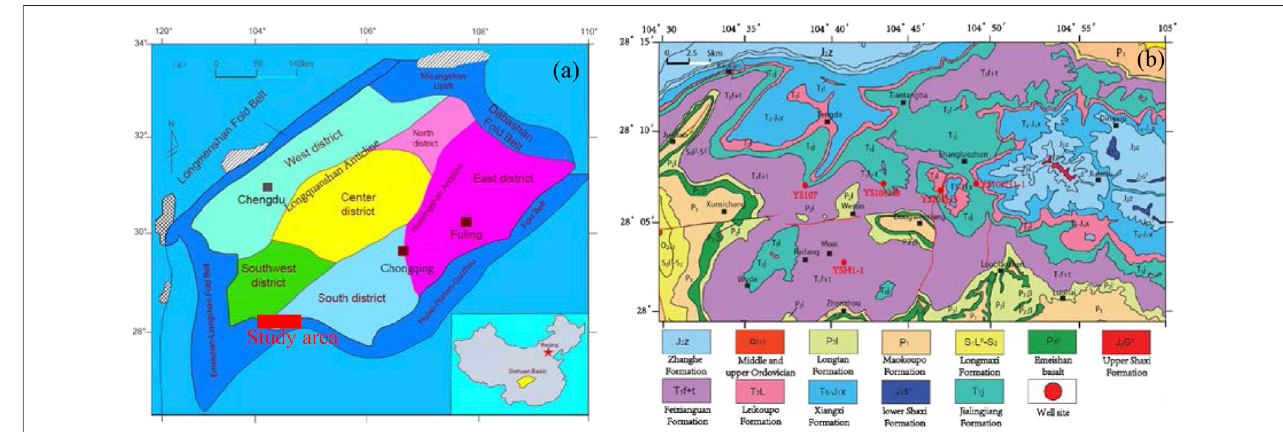
FIGURE 1 | (A) Location and paleogeographic map of the study area in south Sichuan Basin, and the structural subdivisions include the east district, the south district, the north district, the central district the (modi fi ed from Chen et al. (2016), Hao et al. (2008)). (B) Geological map of study area, showing sample sites.